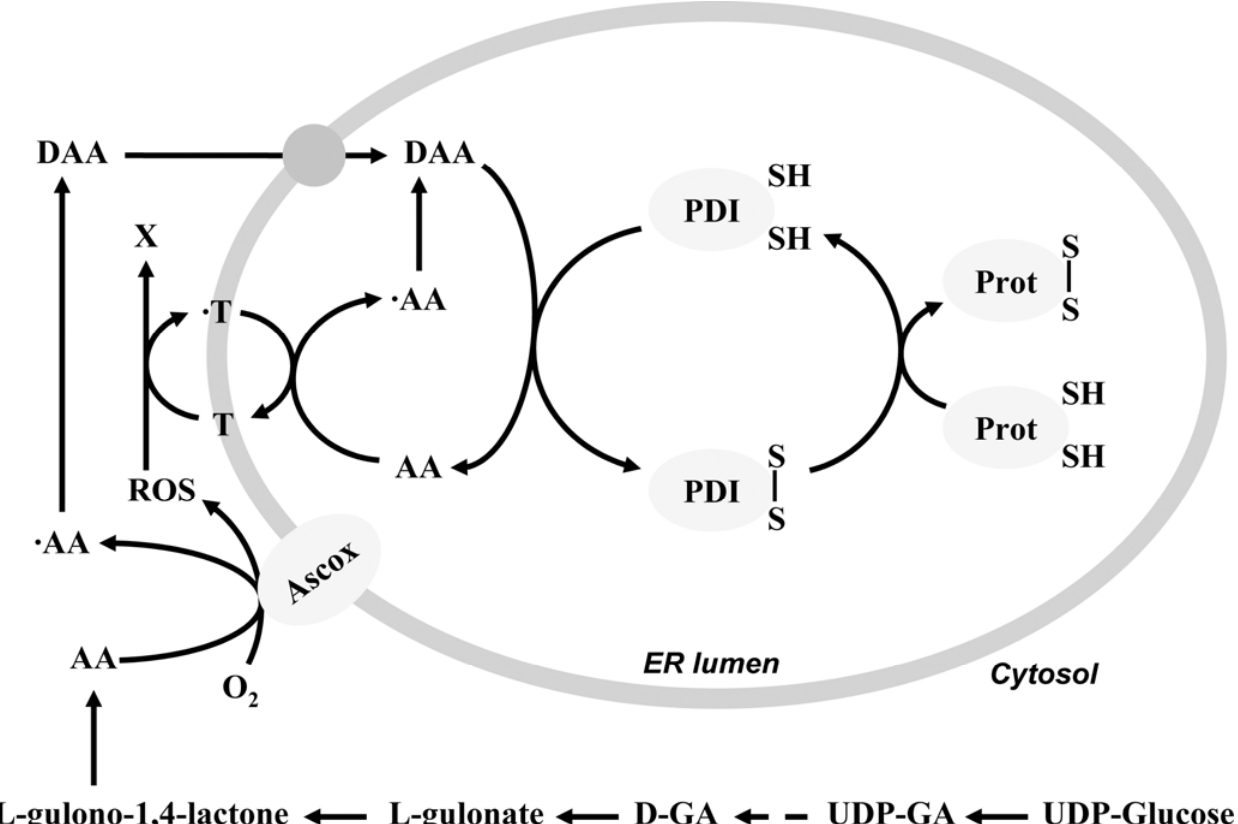
Figure 2. The role of ascorbate and tocopherol in the oxidative protein folding